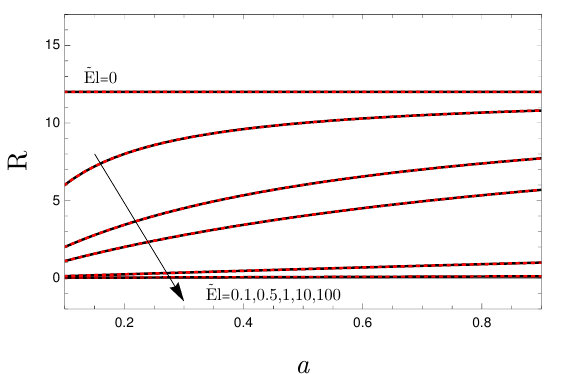
Figure 3. Comparison between asymptotic solution for k → 0 (red dashed curves) and the neutral stability condition obtained numerically for k = 10 − 3 (black continuous curves); R versus a